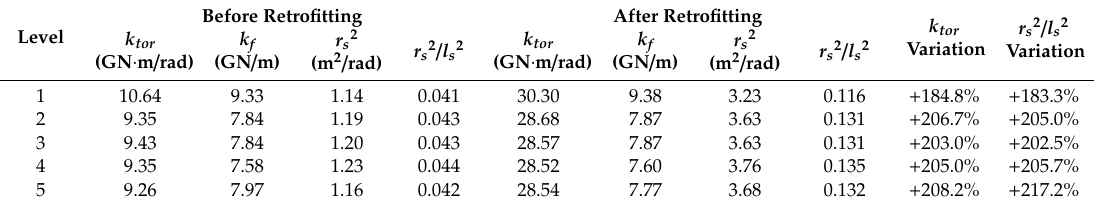
Table 5. Comparison of torsional stiffness and deformability of building B before and after retrofitting.